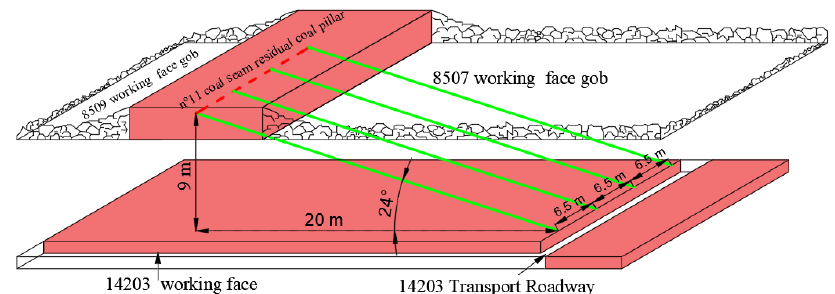
Figure 10. Construction drawing of coal pillar weakening release drilling.